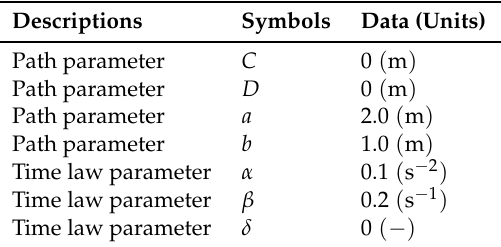
Table 2. State-space trajectory parameters.